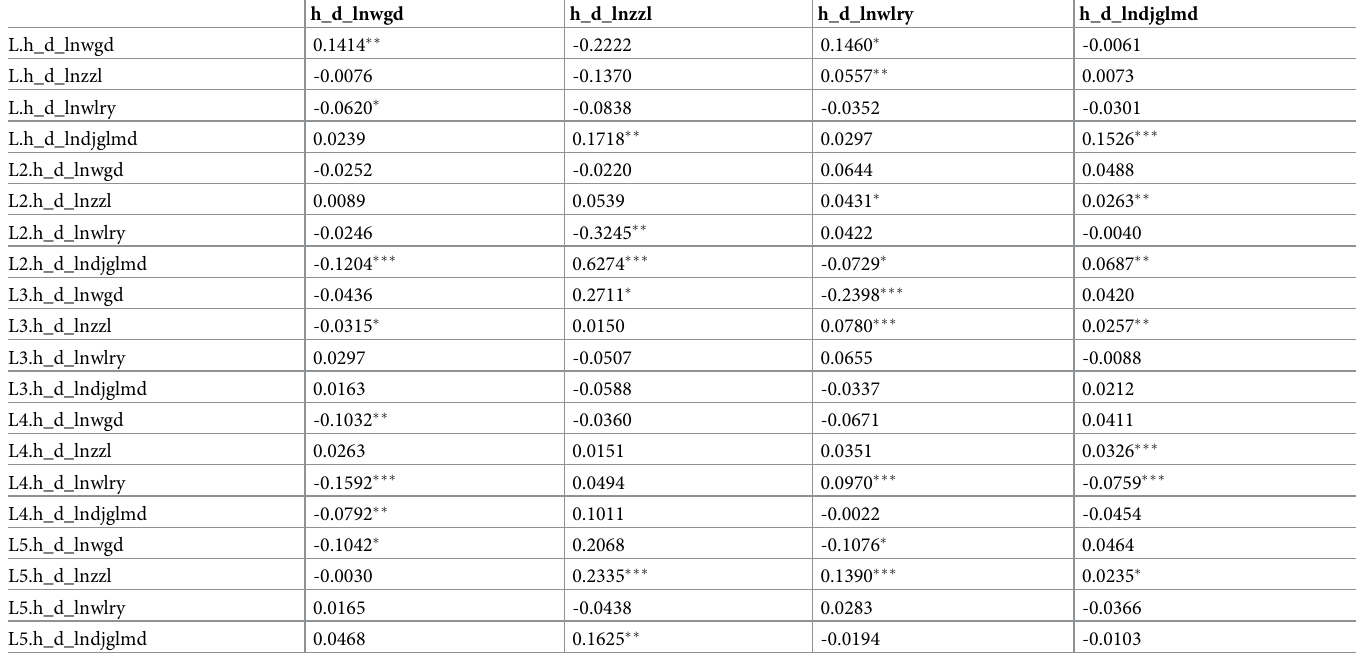
Table 22. GMM estimation results of PVAR model for logistics industry and the efficiency of two-industry-linkage.